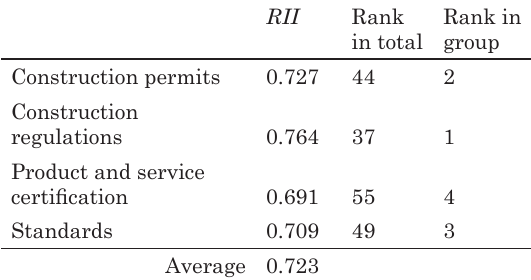
table 2. Summary of survey results